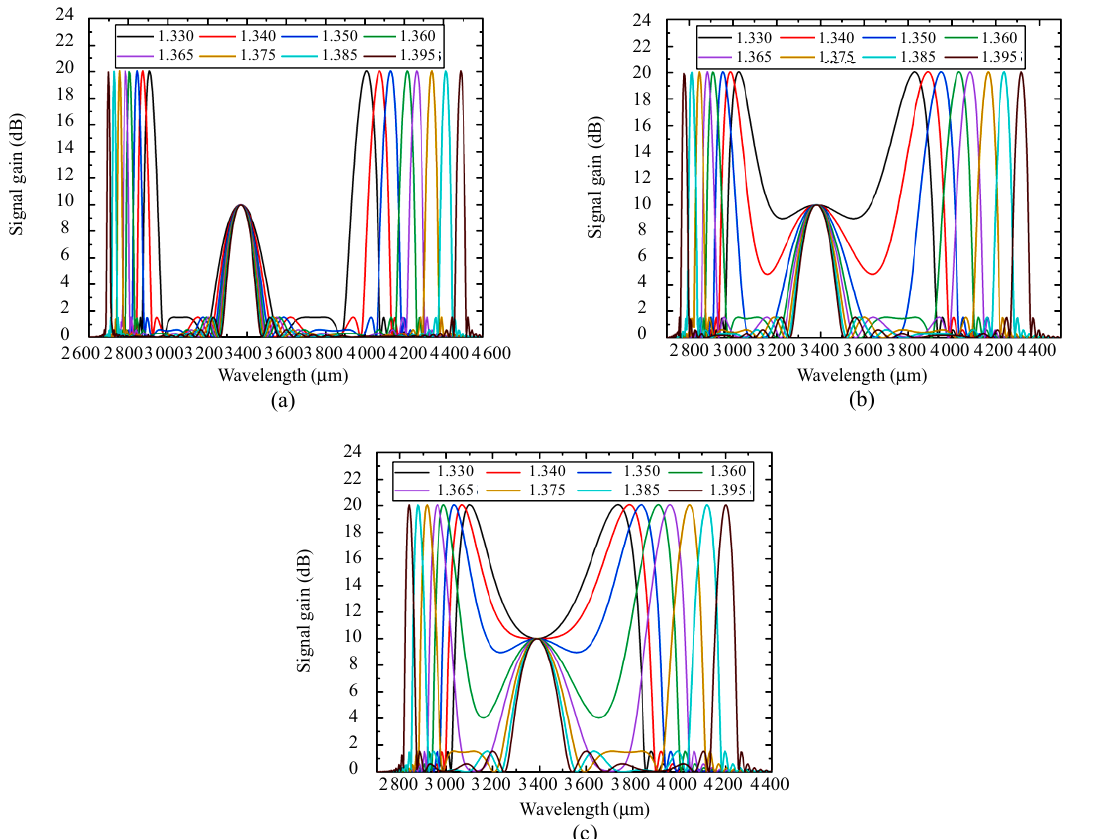
Fig. 5 RI changes from 1.33 to 1.395 and the FWM spectrum changes with pump light wavelengths of (a) 3 370 nm, (b) 3 380 nm, and (c) 3 390